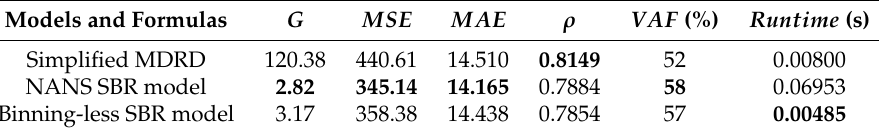
Table 4. Modeling adult patients’ GFR data: Generalization/roughness index ( G ), mean squared error ( MSE ), mean absolute error ( MAE ) and coefficient of correlation ( ρ ) for the four considered estimation models (simplified MDRD formula independent of age and gender, numerical-algebraic neural-system based statistical bivariate numerical modeling algorithm, and proposed statistical bivariate numerical modeling algorithm). Highlighted values denote best